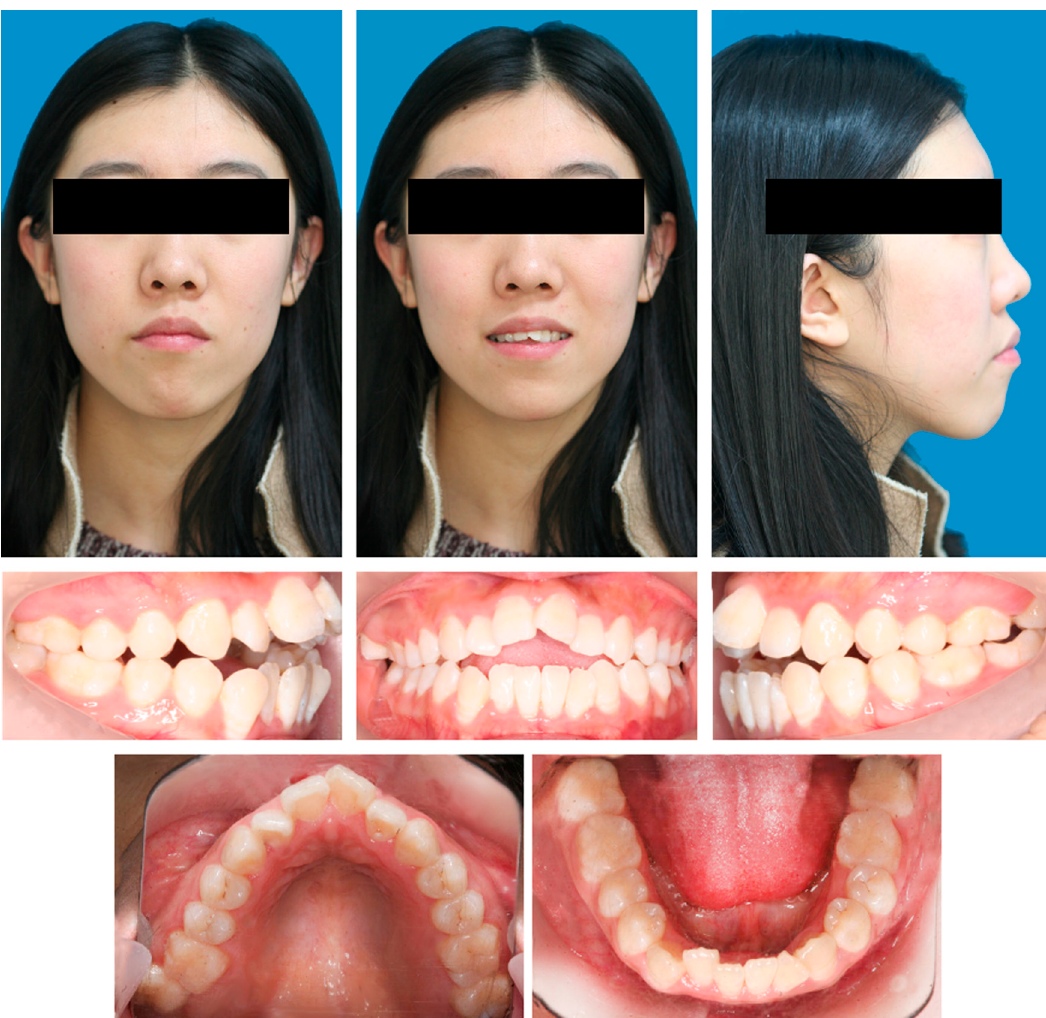
Figure 1. Pre-treatment extraoral and intraoral